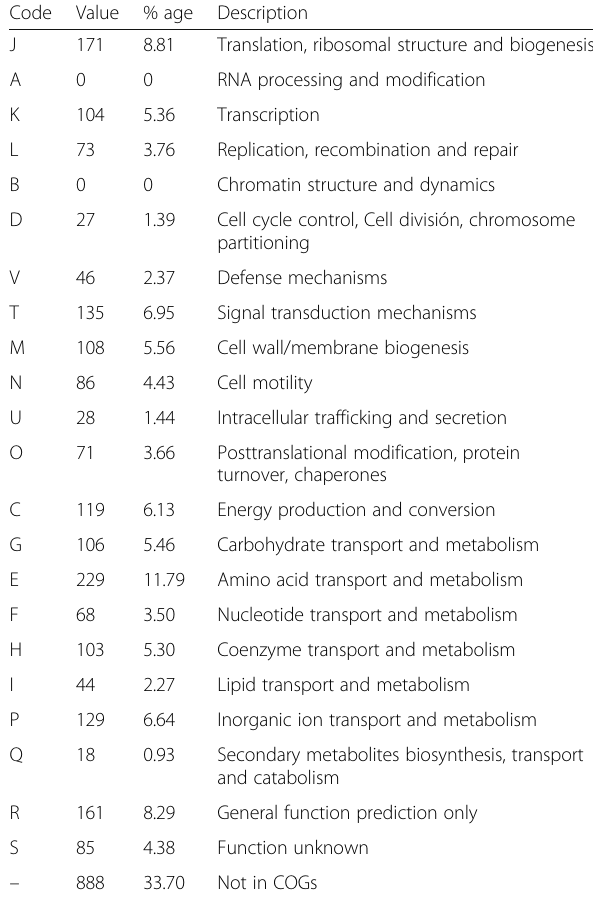
Table 4 Number of genes associated with general COG functional